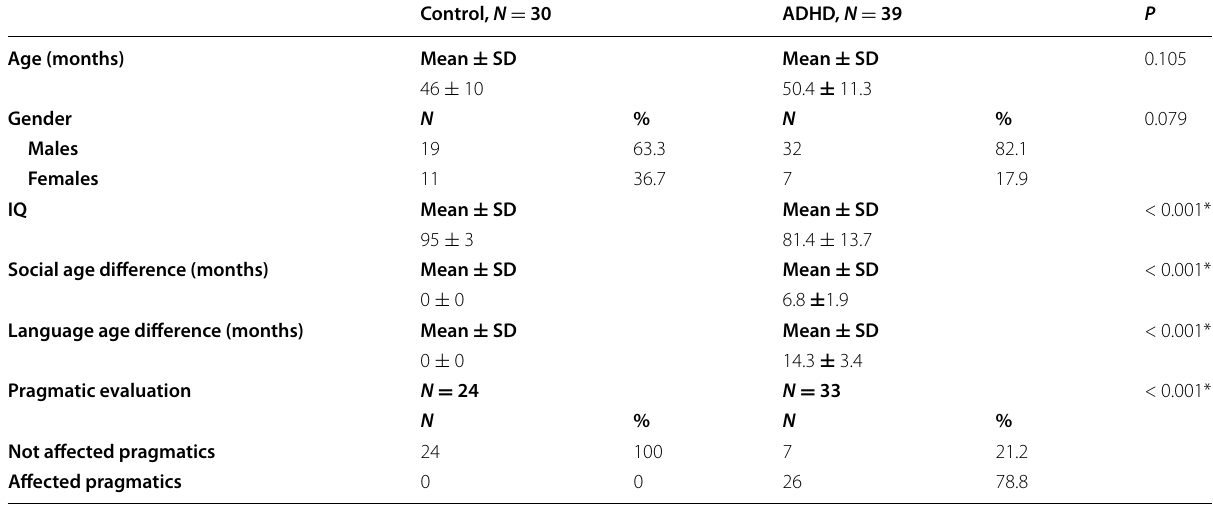
Table 1 Descriptive and comparative analysis of demographic data and psychometric and communicative evaluation of the studied